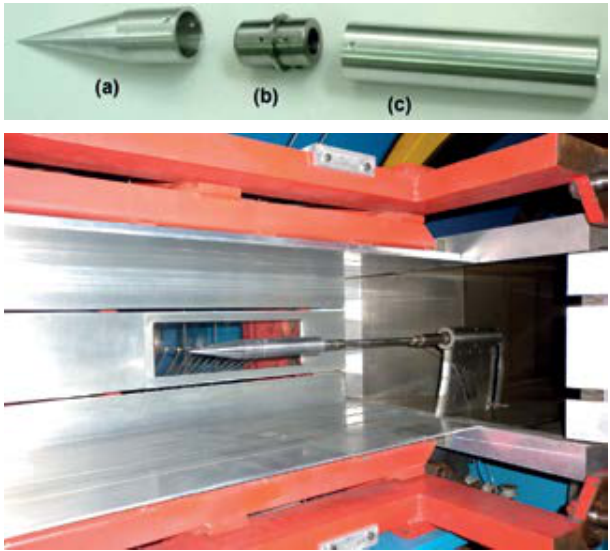
Figure 6. Cone–cylinder model installed in the TTP test section and in an exploded view, showing the forebody (a); the internal intermediate piece (b); and the cylindrical part